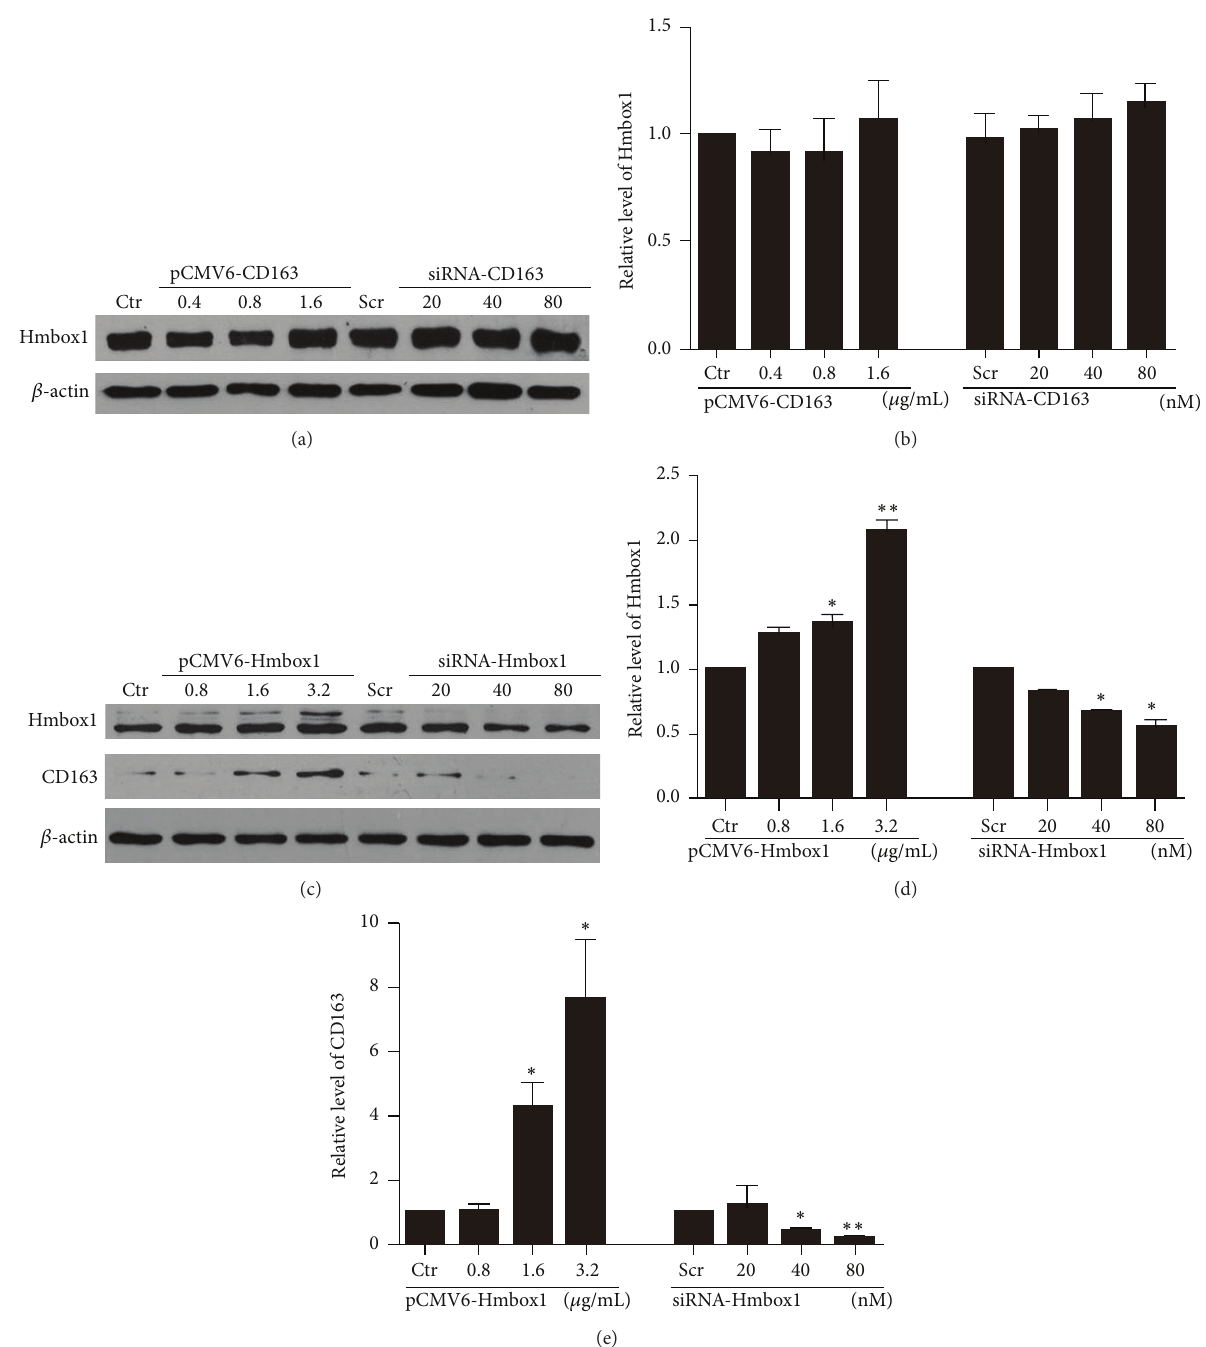
Figure 4: CD163 acted downstream Hmbox1 in differentiation of BMSCs towards a VEC lineage. (a) Western blot analysis of the protein level of Hmbox1 after overexpression or knockdown of CD163. (b) Relative protein levels of Hmbox1 were calculated based on densitometry analysis. (c) Western blot analysis of the protein level of Hmbox1 and CD163 after overexpression or knockdown of Hmbox1. For Hmbox1 overexpression, BMSCs were transfected with pCMV6 empty vector (as control) at 3.2 𝜇 g/mL or pCMV6-Hmbox1 at 0.8, 1.6, or 3.2 𝜇 g/mL for 4 h and cultured for 48 h. For Hmbox1 interference, cells were subjected with 80 nmol/L scrambled siRNA or 20, 40, and 80 nmol/L Hmbox1 siRNA for 6 h and cultured for 48 h. Scr: scrambled RNA as negative control. ((d)-(e)) Relative protein levels of Hmbox1 and CD163 were calculated based on densitometry analysis. Data are mean ± SEM. ∗ 𝑝 < 0.05 , ∗∗ 𝑝 < 0.01 versus control (Ctr), 𝑛 ≥ 3